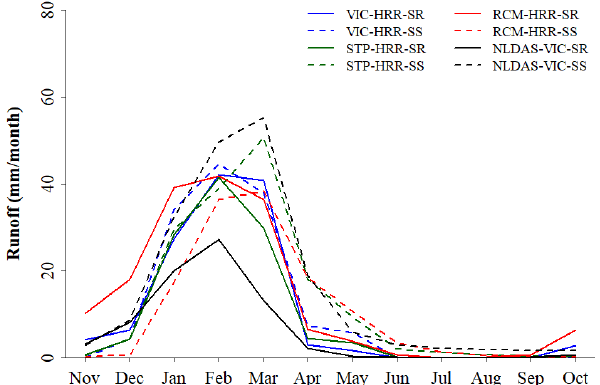
Figure 4. Simulated monthly surface and subsurface runoff for the Mission Creek watershed (USGS gauge no. 11119750) by three models for the calibration period (water year 1985–2005). Surface runoff is denoted by “SR” and subsurface runoff is denoted by “SS” in this figure. Monthly surface and subsurface runoff from National Land Data Assimilation Systems (NLDAS) VIC model simulation for the same period are shown here for comparison purposes.